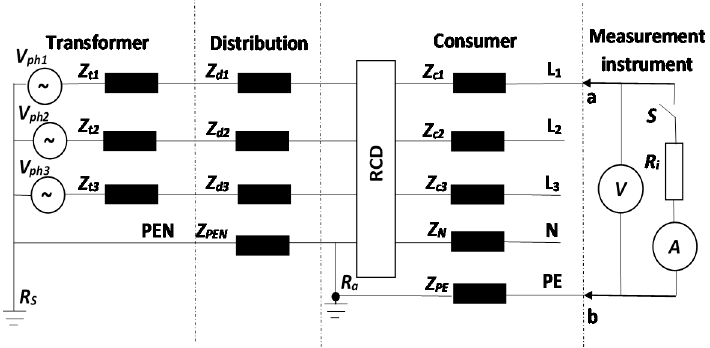
Figure 2. Simplified equivalent circuit during earth fault loop impedance measurement